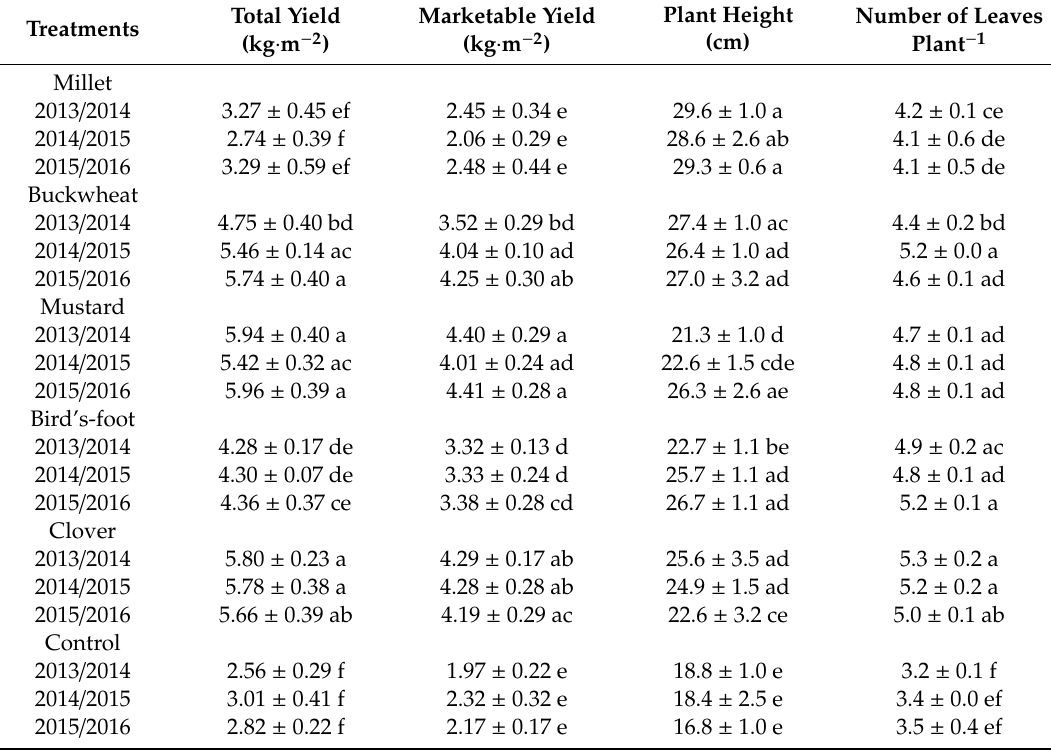
Table 4. Yield and plant biometric traits of winter garlic crop as affected by ‘mulch type × year’ interaction. Total Treatments